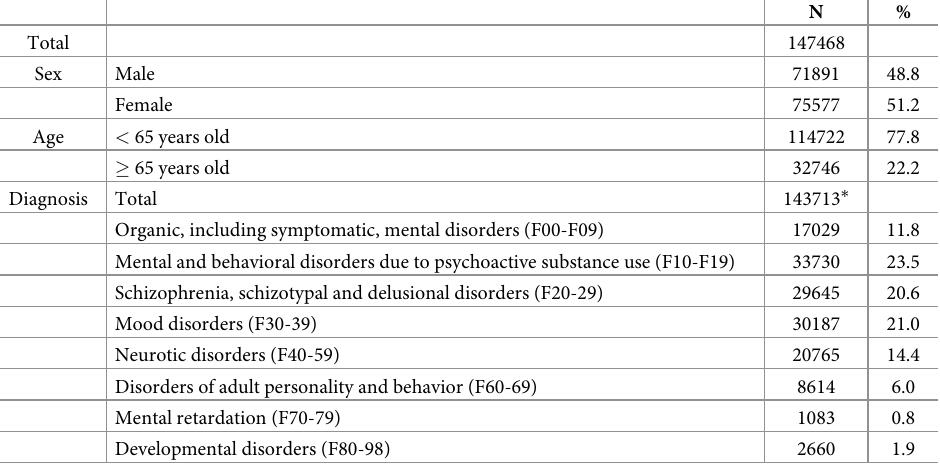
Table 1. Summary statistics of hospital admissions due to mental disorders in the eight main cities in Switzerland during 2009–2019.